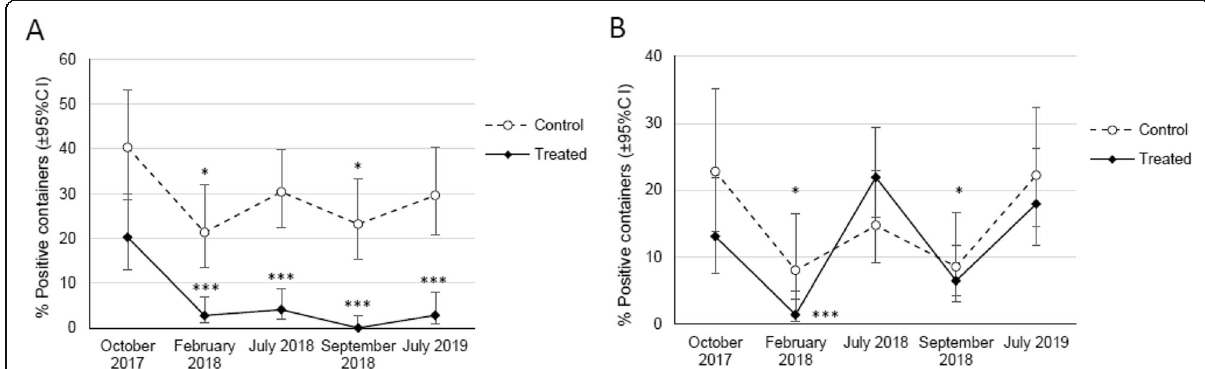
Fig. 2 Results of the larval surveys of the control and treated villages conducted during the pre-intervention and intervention periods. a The prevalence rate of Ae. aegypti species in pre-intervention period (October 2017) in the control village (23/57) and the treated village (17/84), followed by intervention periods, in February 2018 (16/75, 4/143), in July 2018 (31/102, 6/146), in September 2018 (19/82, 0/140), and in July 2019 (24/81, 3/106). b The prevalence rate of Ae. albopictus species in pre-intervention period (October 2017) in the control village (13/57) and the treated village (11/84), followed by intervention periods, in February 2018 (6/75, 2/143), in July 2018 (15/102, 32/146), in September 2018 (7/82, 9/140), and in July 2019 (18/81, 19/106). P values were calculated using